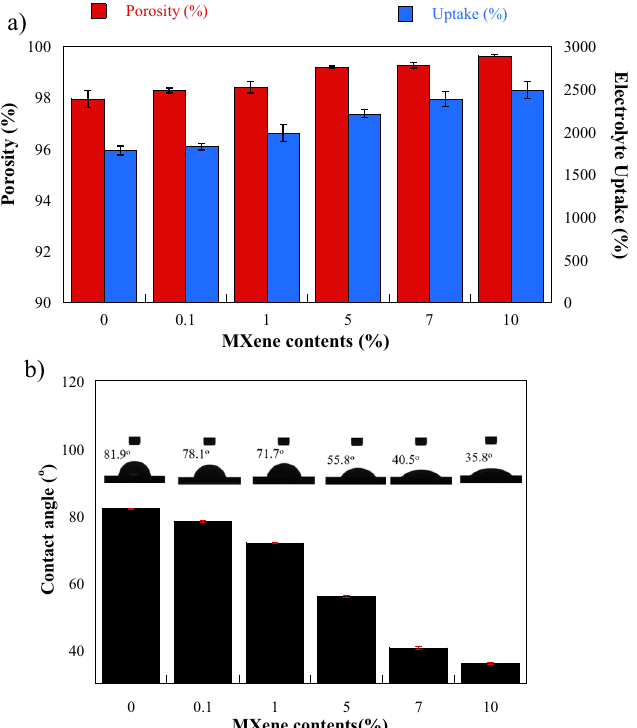
Figure 8. Representative ( a ) porosity (red) and electrolyte uptake (blue) and ( b ) schematic of contact angle test of PAN/bio-based PU/Ti 3 C 2 T x MXene composite.